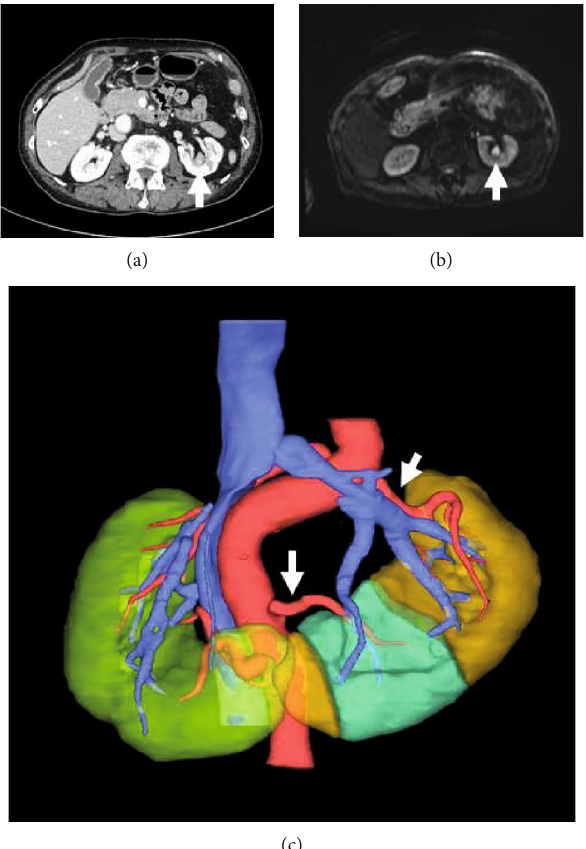
Figure 1: (a) CT fi ndings. CT reveals a mass lesion of upper pelvis of the left side of the horseshoe kidney (arrow). (b) MRI fi ndings. MRI reveals a high signal intensity on di ff usion-weighted imaging (arrow). (c) Reconstruction of three-dimensional analysis of the images of thin- slice contrast-enhanced CT. Three-dimensional reconstruction reveals two renal arteries arising from the aorta that supplied to the left side of the horseshoe kidney (arrow).